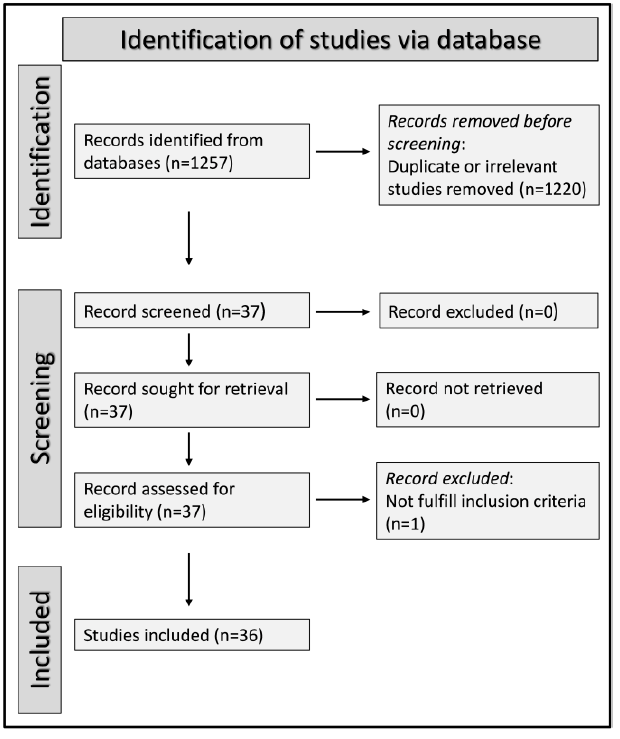
Figure 1. PRISMA 2020 flow diagram. Table 1. Characteristics of the studies investigating the association between body mass index and adverse outcomes in idiopathic pulmonary fibrosis.